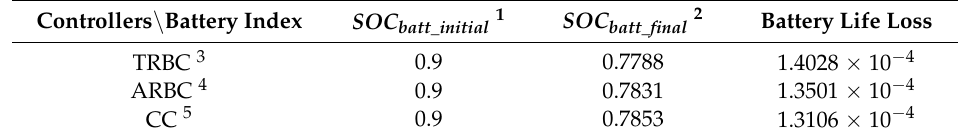
Table 8. SOC and life loss of